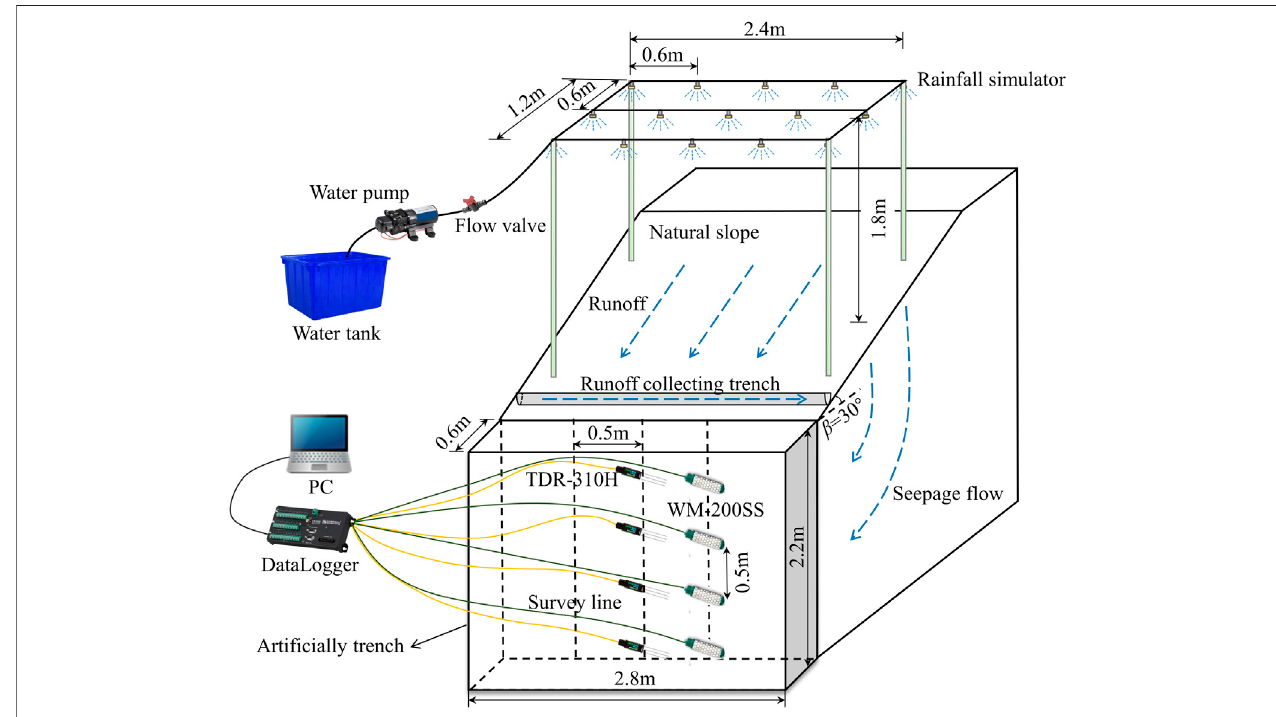
FIGURE 11 | In- situ simulated rainfall test